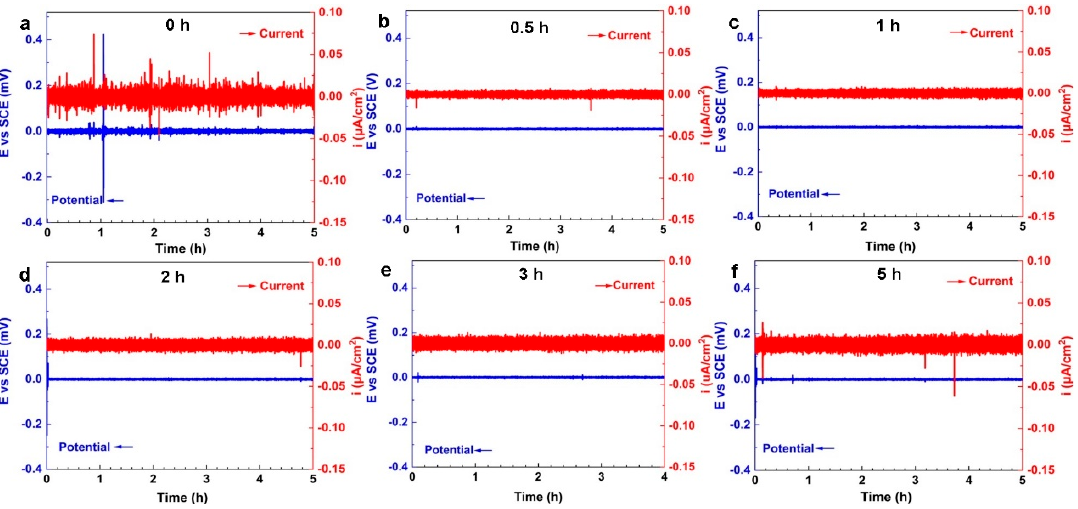
Figure 6. The electrochemical potential noise (EPN) and electrochemical current noise (ECN) signals of NAB after different CE times: ( a ) 0 h; ( b ) 0.5 h; ( c ) 1 h; ( d ) 2 h; ( e ) 3 h; ( f ) 5 h.